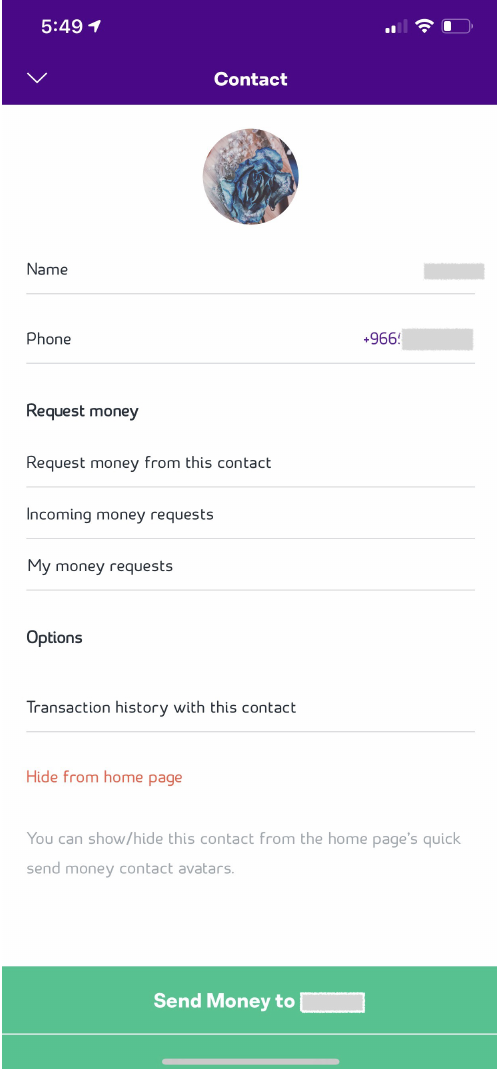
Figure 3. A screenshot showing sending money to a user via STC Pay